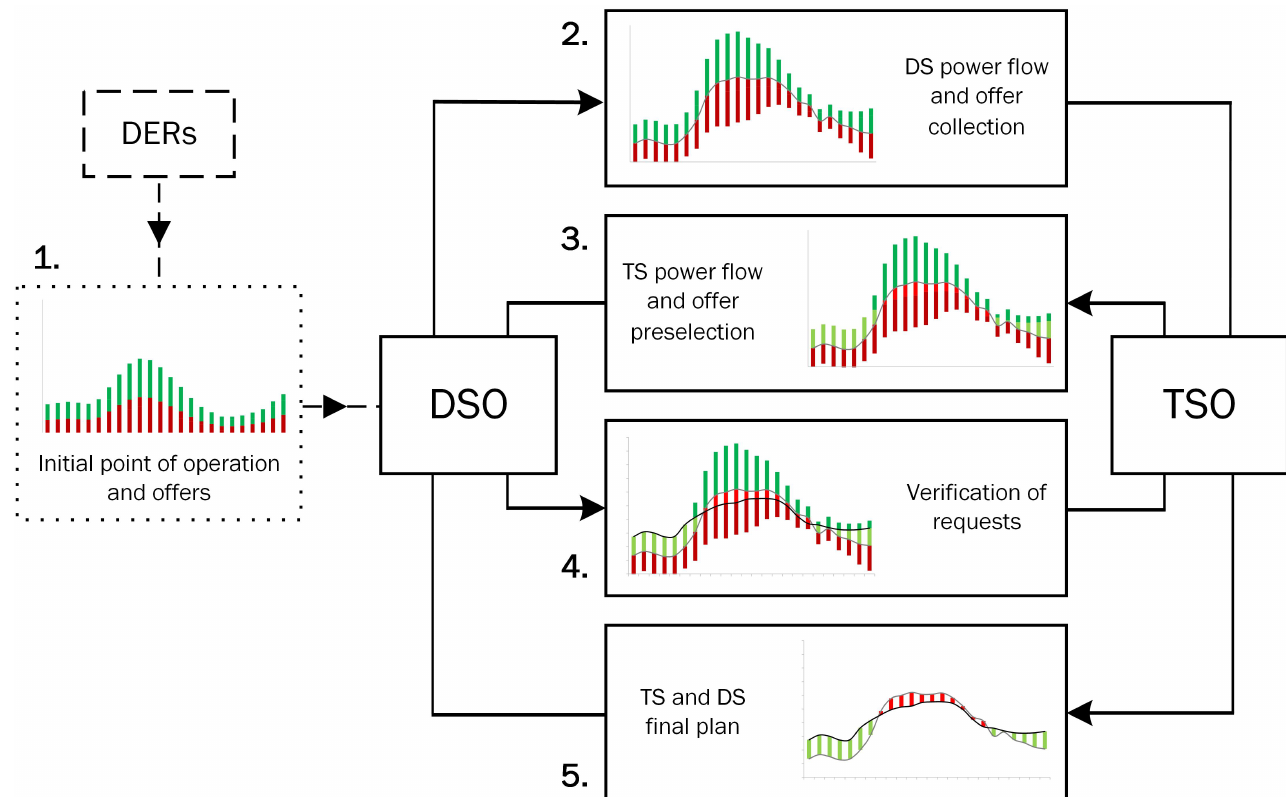
Figure 2. Phases in TSO–DSO coordination with a profile resulting from each